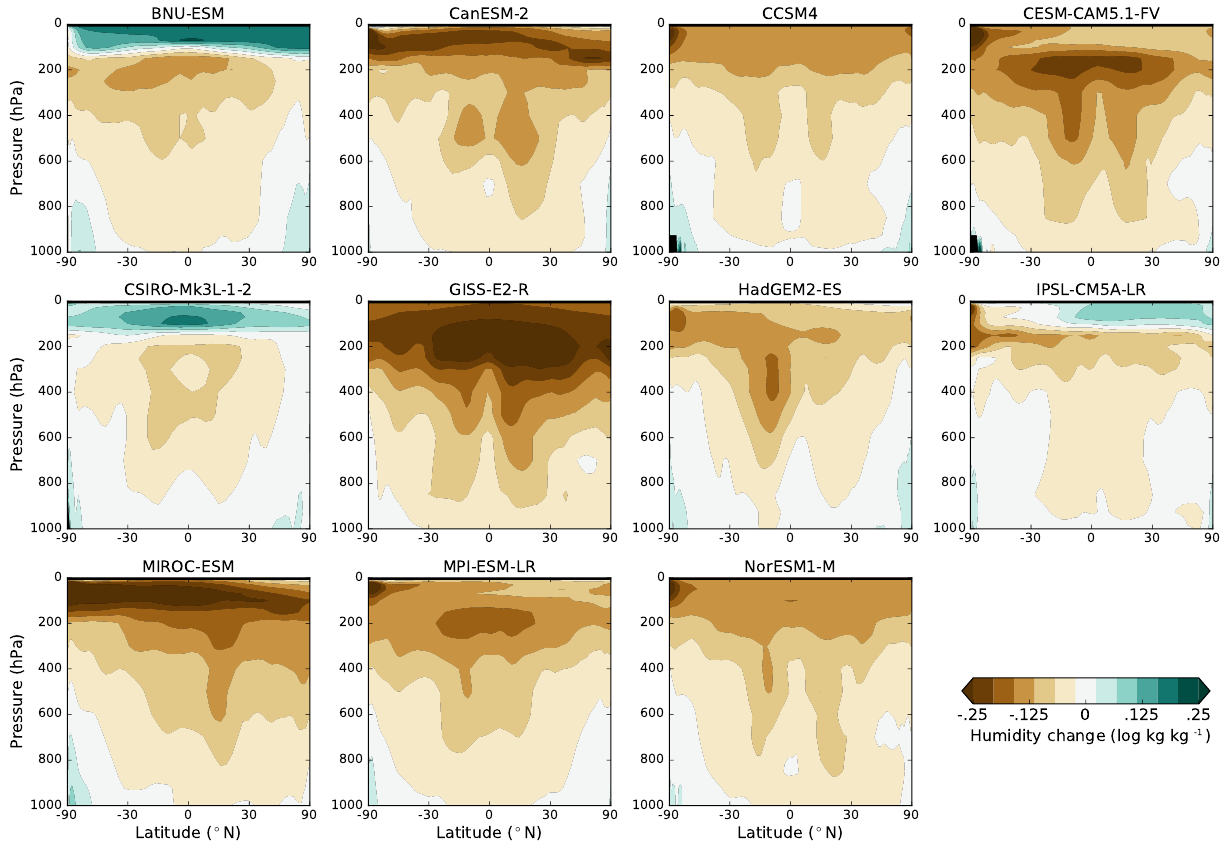
Figure 3. Zonal mean change in the natural log of specific humidity for G1 – piControl in each model as a function of pressure.